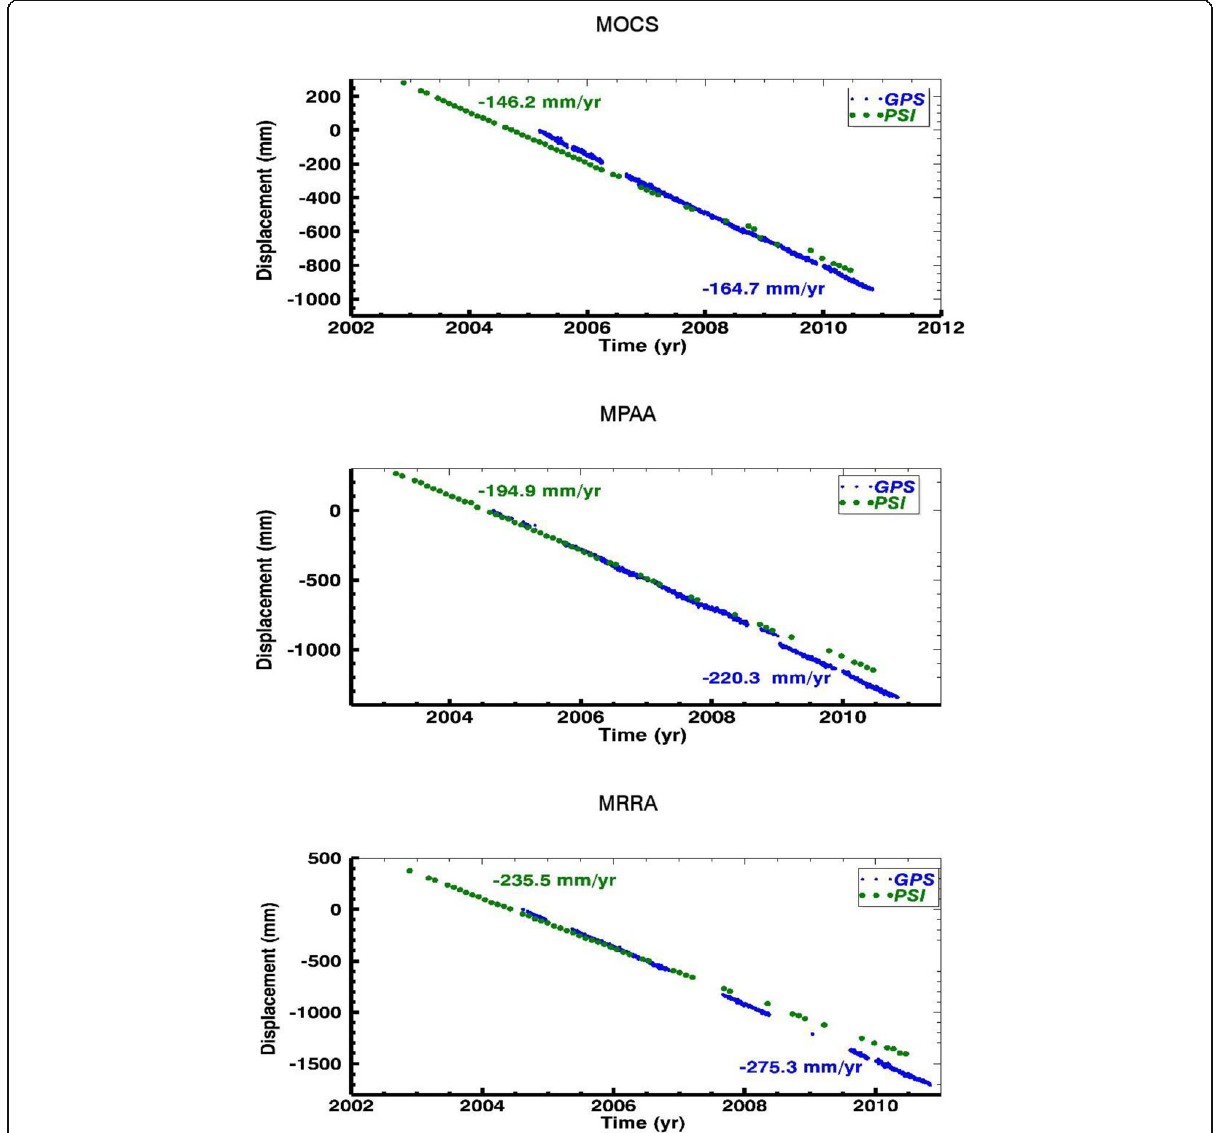
Fig. 12 Comparison of three PSs time series with (vertical) GPS data. For each graph, the closest PS to three GPS stations of MOCS, MPAA, and MRRA (see Fig. 1 for the location of these GPS stations) is given. Deformation rates of each methodology are presented in the corresponding